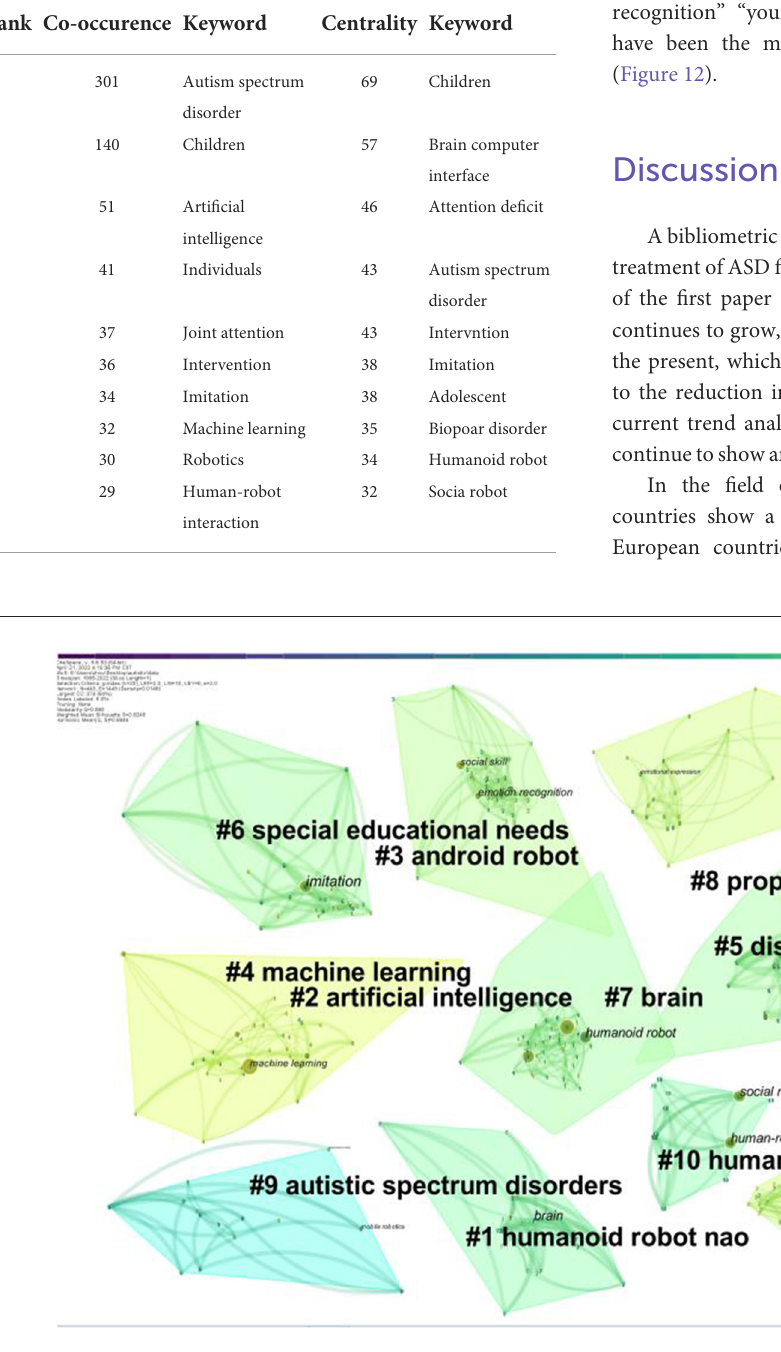
FIGURE10 The cluster map of co-occurence keywords related to Al on